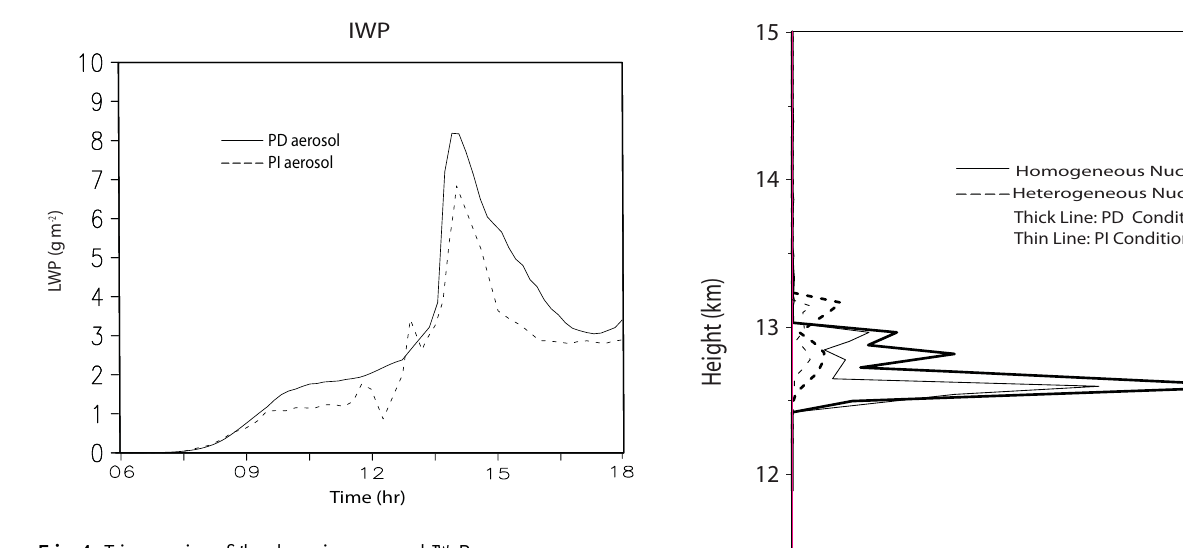
Fig. 4. Time series of the domain-averaged IWP.